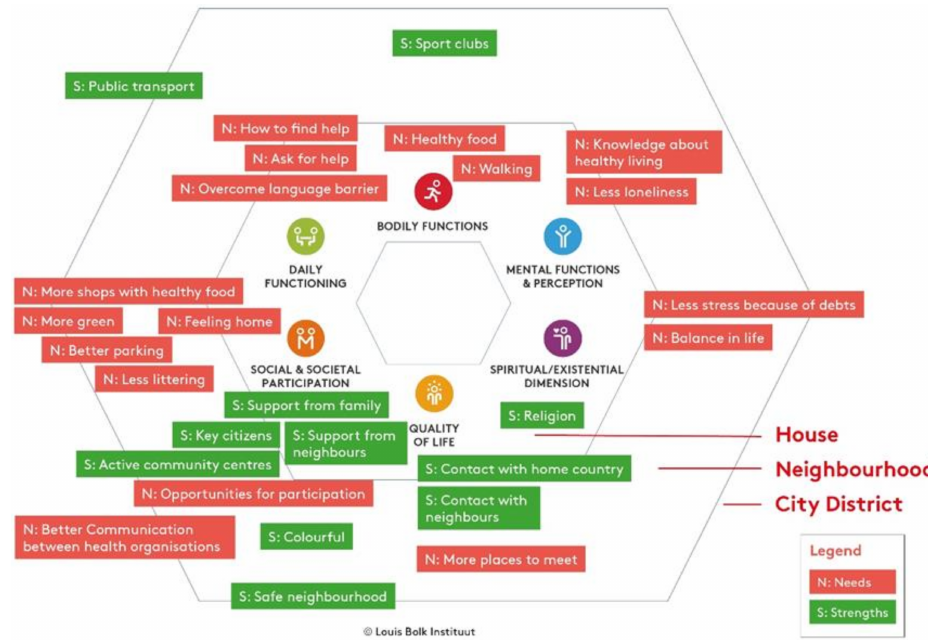
Figure 4. Mapping needs and strengths of residents in the Bolk